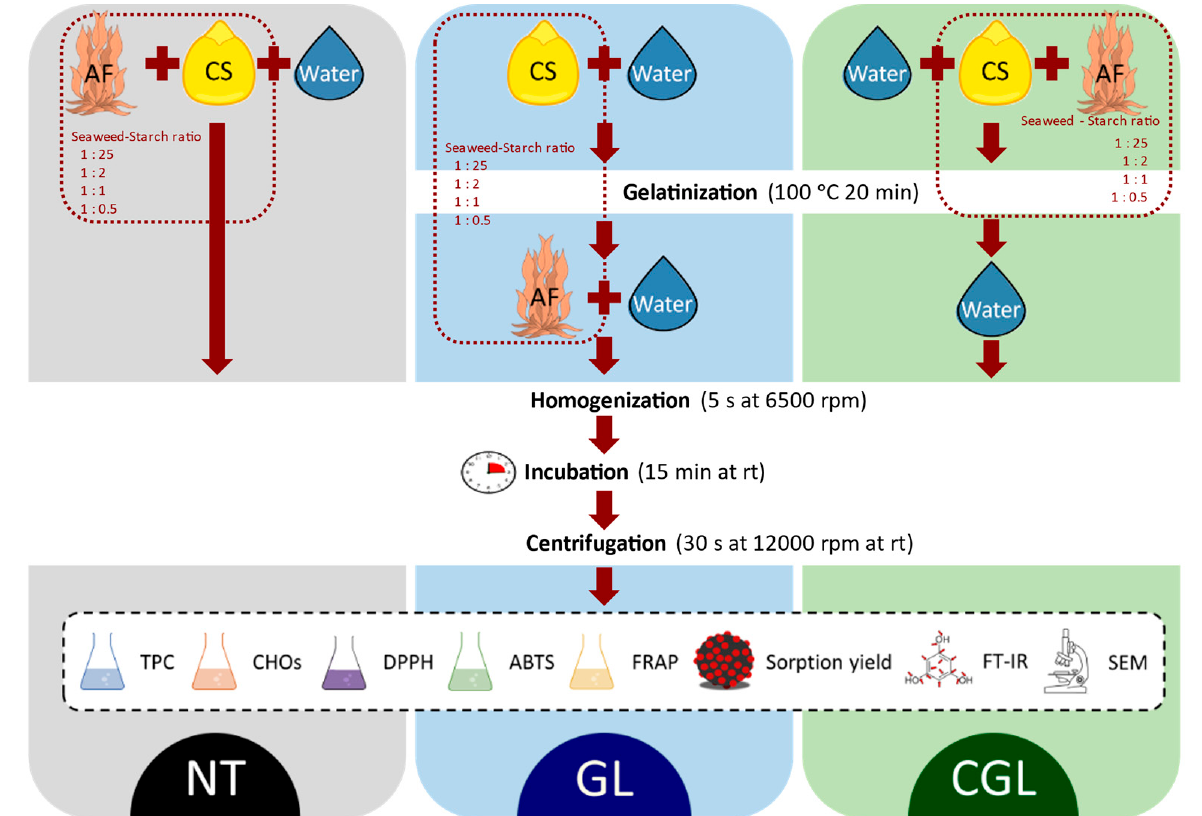
Figure 1. Process scheme summarizing methodology. NT method: AF (seaweeds flour) and native corn starch (CS) blending; GL method: AF and gelled CS blending; CGL method: CS gelatinized in the presence of AF.